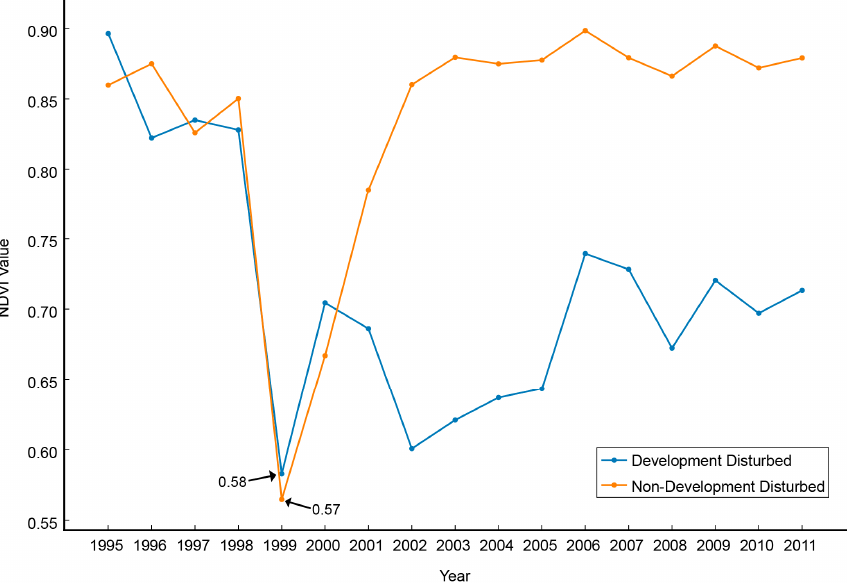
Figure 3. Classes Development Disturbed and Non-Development Disturbed over time. Both were flagged as the low in 2003. Development Disturbed remains lower than Non-Development Disturbed through the remainder of the time series and is much more constant. These are two vector representations, but are not representative of all possible vectors.